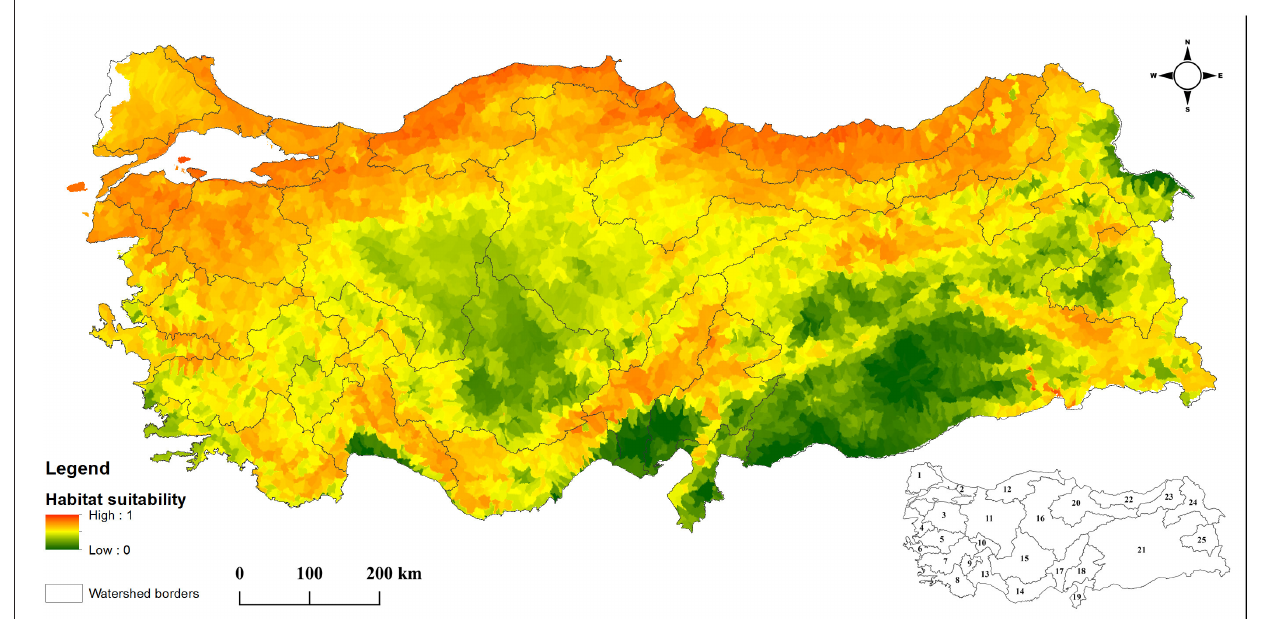
FIGURE 2 | Habitat suitability map of Oncorhynchus mykiss in Turkey. The inset at the bottom-right corner shows the codes for 25 river basins namely 1, Maritza-Ergene; 2, Marmara; 3, Susurluk; 4, North Aegean; 5, Gediz; 6, Small Menderes; 7, Great Menderes; 8, Western Mediterranean; 9, Burdur; 10, Akarçay; 11, Sakarya; 12, Western Black Sea; 13, Antalya; 14, Eastern Mediterranean; 15, Konya Closed Basin; 16, Kizilirmak; 17, Seyhan; 18, Ceyhan; 19, Orontes; 20, Ye¸silirmak; 21, Euphrates and Tigris; 22, Eastern Black Sea; 23, Çoruh; 24, Kura and Aras; 25, Lake Van Basin.